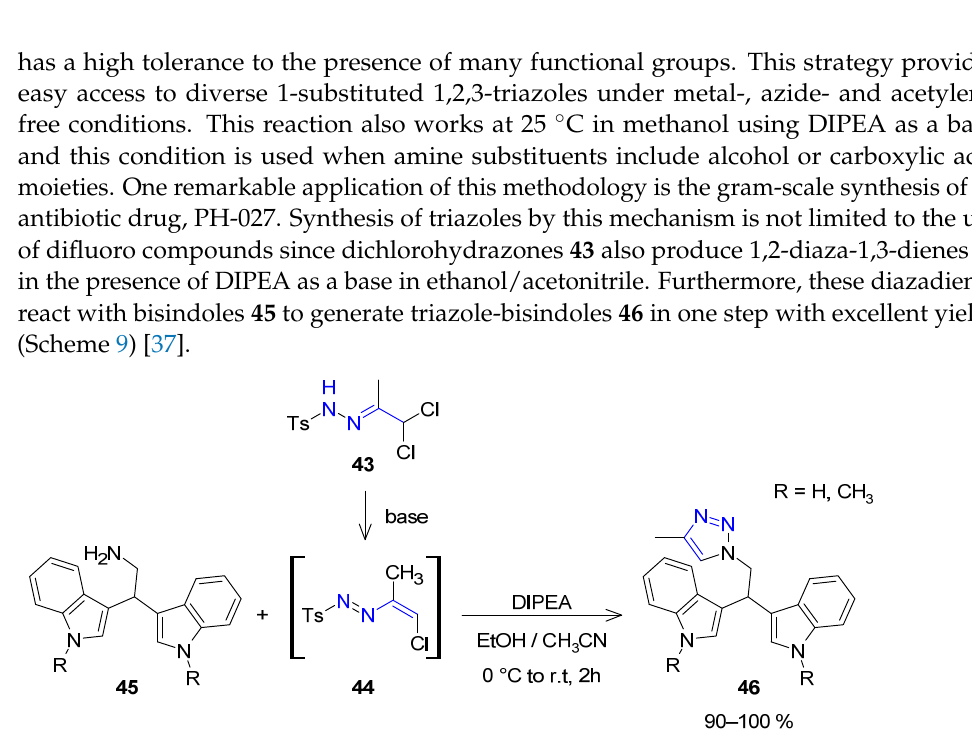
Scheme 8. Triazole synthesis from amines and 1,2 ‐ diaza ‐ 1,3 ‐ dienes generates in situ